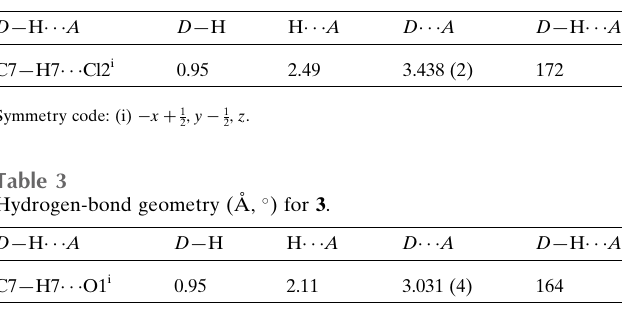
Table 2 Hydrogen-bond geometry (A˚ , (cid:2) ) for 2 .